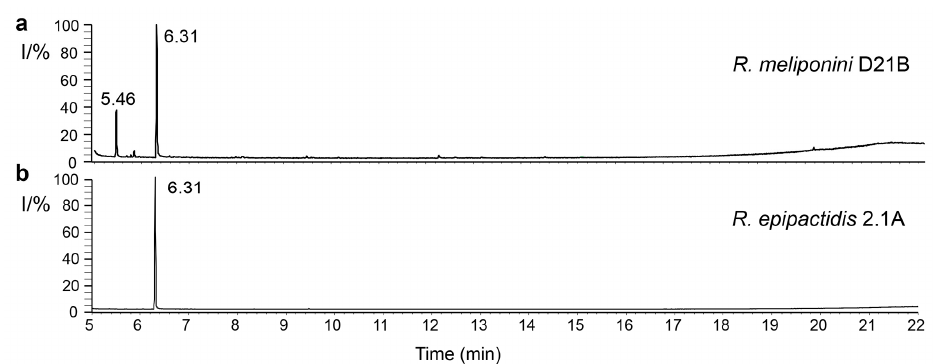
Figure 8. Comparison of total ion current chromatograms of ( a ) R. meliponini D21B and ( b ) R. epipactidis 2.1A spent medium of ethyl acetate extracts after derivatization with MSTFA. The two major observable products were identified as 2-phenylethanol (RT 5.46 min) and 2-phenylacetic acid (RT 6.31 min). See Supplementary Materials for EI-MS